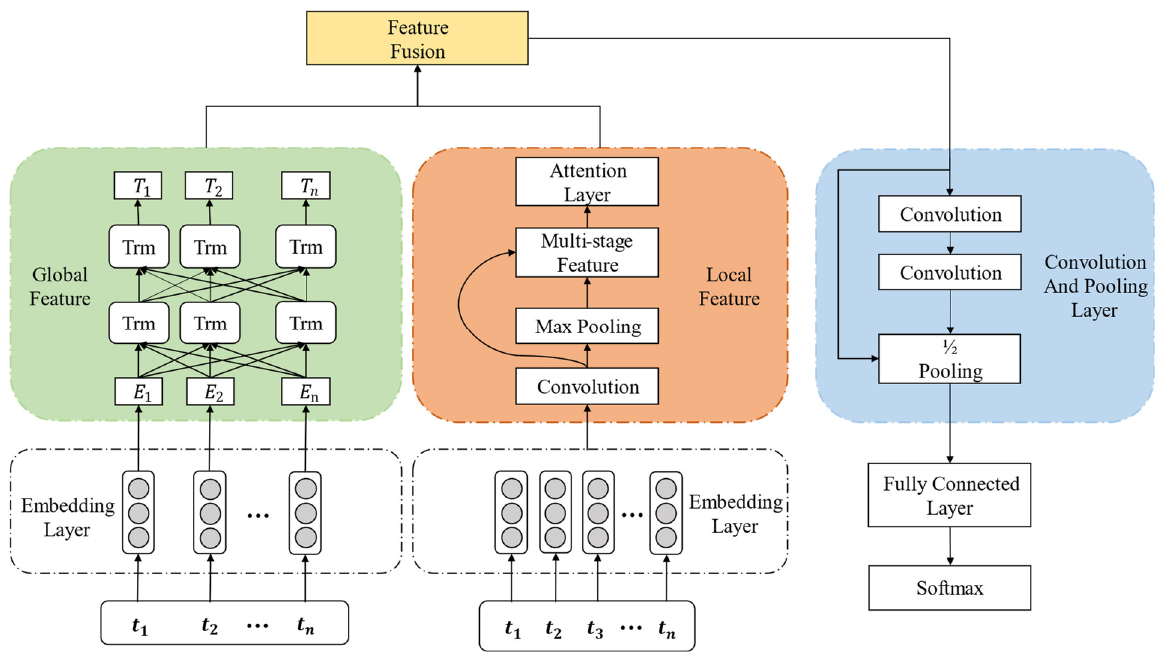
Figure 1. BTCDC network structure.